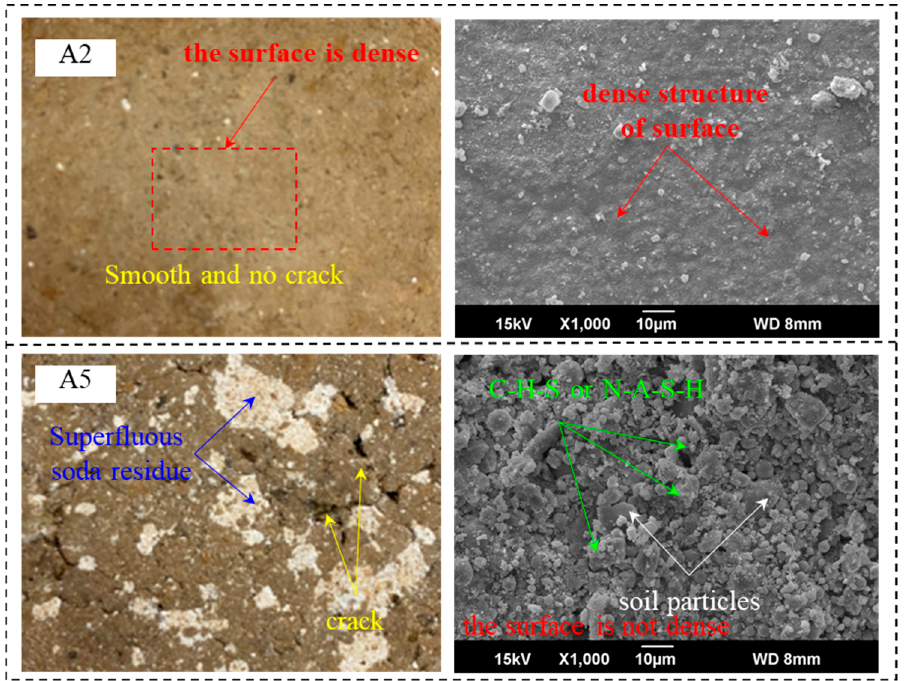
Figure 8. Partial live shot and electron microscope scanning of specimens of groups A2 and A5.